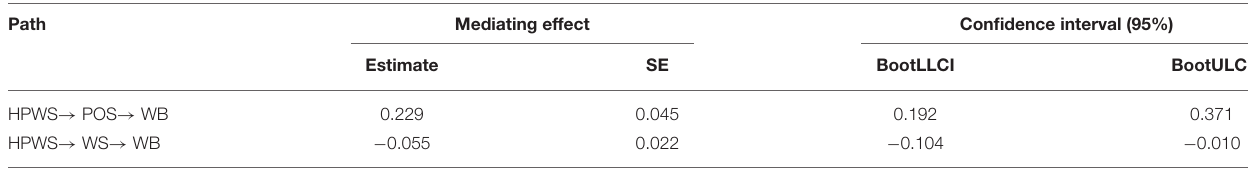
TABLE 3 | Mediating effect of perceived organizational support and work stress.